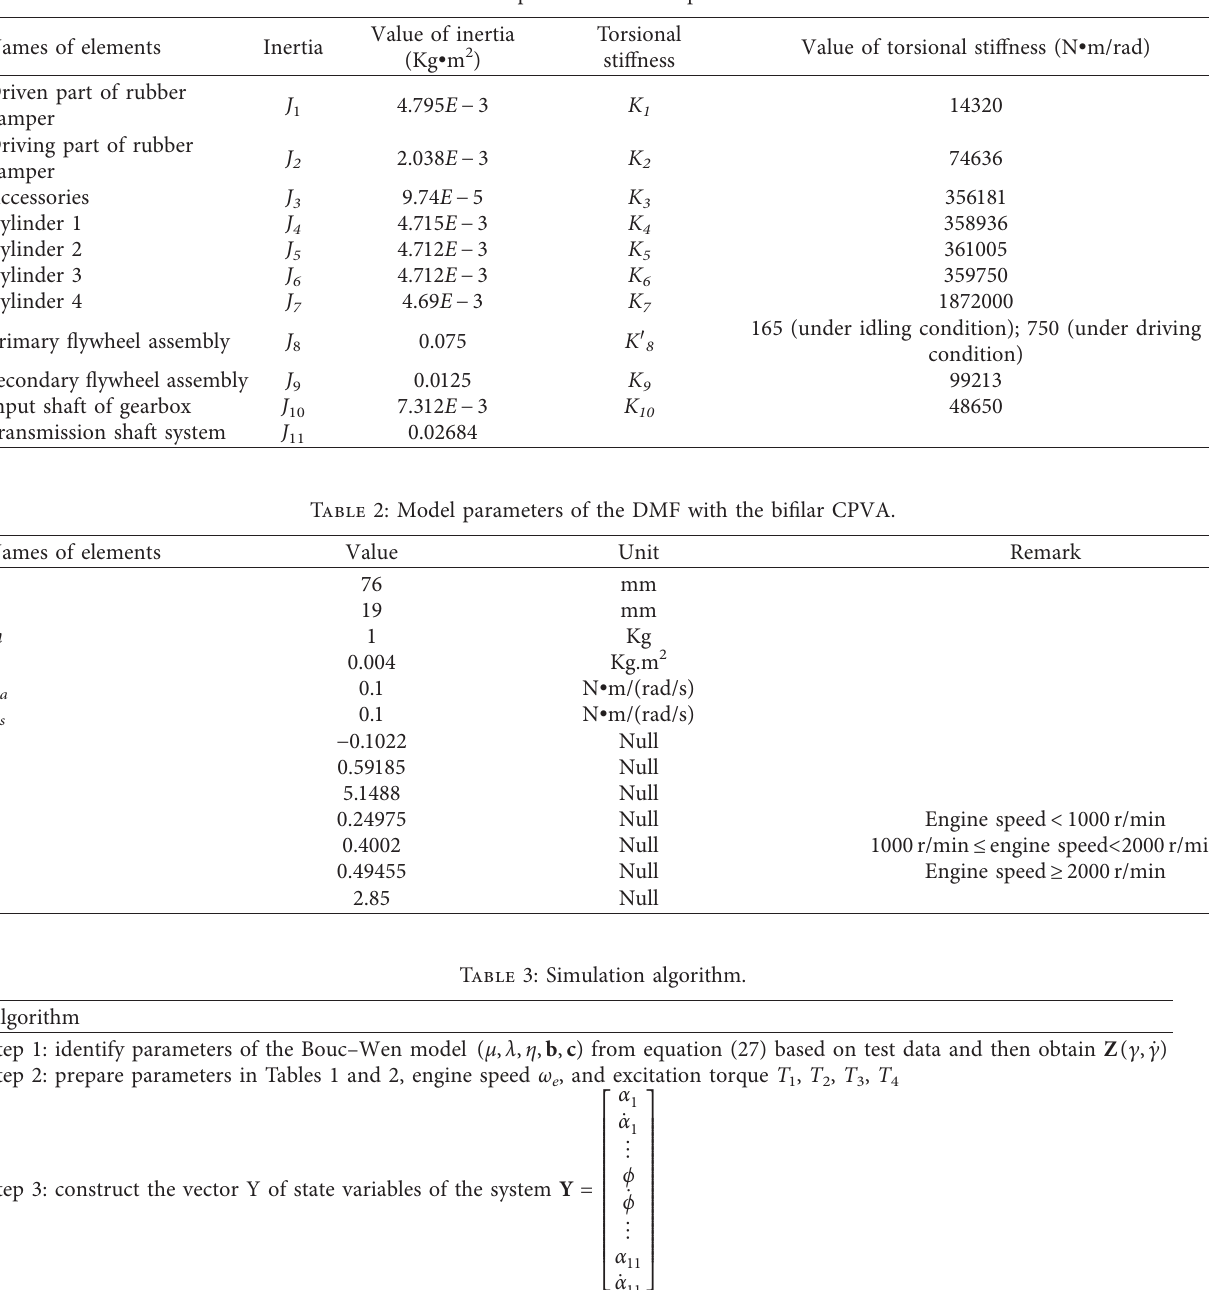
Table 1: Structural parameters of the power transmission.